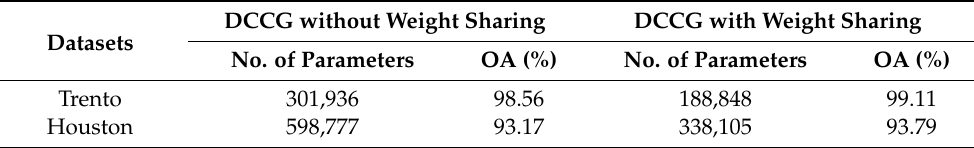
Table 6. Changes in the number of model parameters by the weight-sharing module.